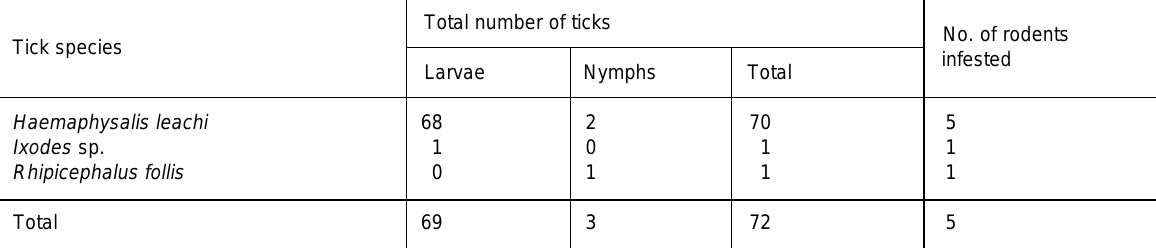
TABLE 5 Ixodid ticks collected from 13 Rattus rattus in the Grahamstown